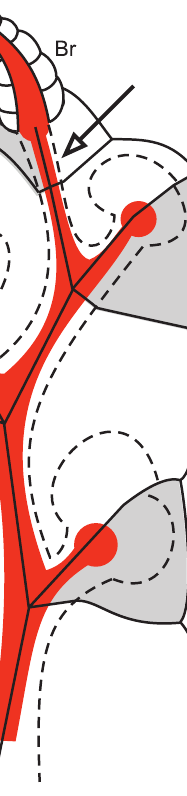
Fig. 14. Subterminal branching in the ambulacra of the callocystitid Callocystites fresti Paul, 2015a (SM A.85652), Wenlock (Silurian), Indiana, USA. Open arrow points to the place where the next lateral branch of the radial water vessel would have taken place, but the tip of the radial water vessel was at the top of the brachiole (Br) that arose from the final facet (solid arrow). Thus, branching of the radial water vessel in brachi- ole-bearing echinoderms was always subterminal. Modified from Paul and Hotchkiss 2020: fig. 7.